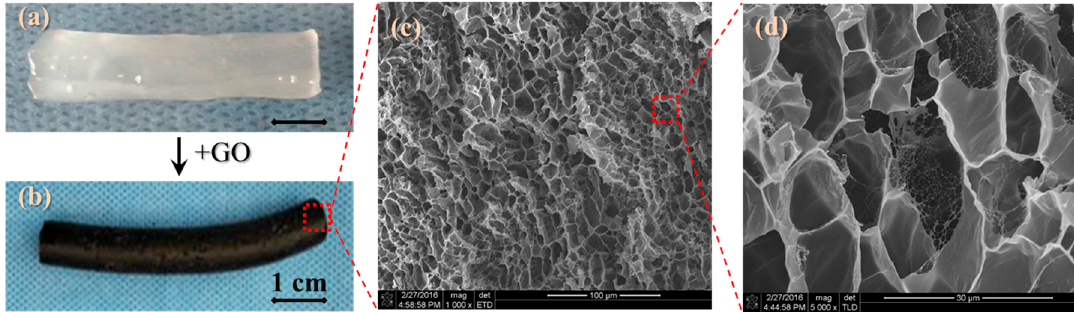
Figure 2. Hydrogel samples of ( a ) PVA/PEG; ( b ) PVA/PEG/GO; and SEM images from ( b ) that ( c ) shows the porous structure of gel under cooled and dried states under 1000× magnification; and ( d ) is a small area of ( c ) under 5000× magnification.